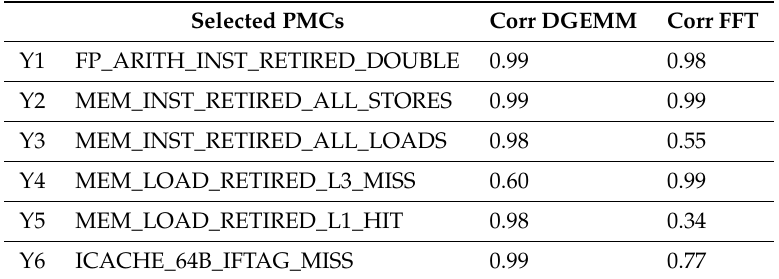
Table 8. Selected PMCs for Class B experiments along with their energy correlation for DGEMM and FFT. 0 to 1 represents positive correlation of 0% to